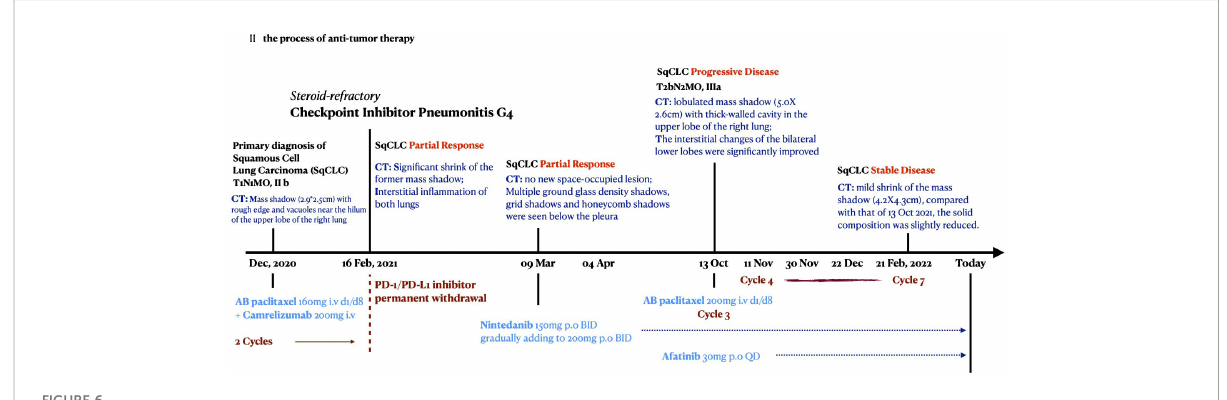
FIGURE 6 The time axis of anti-tumor